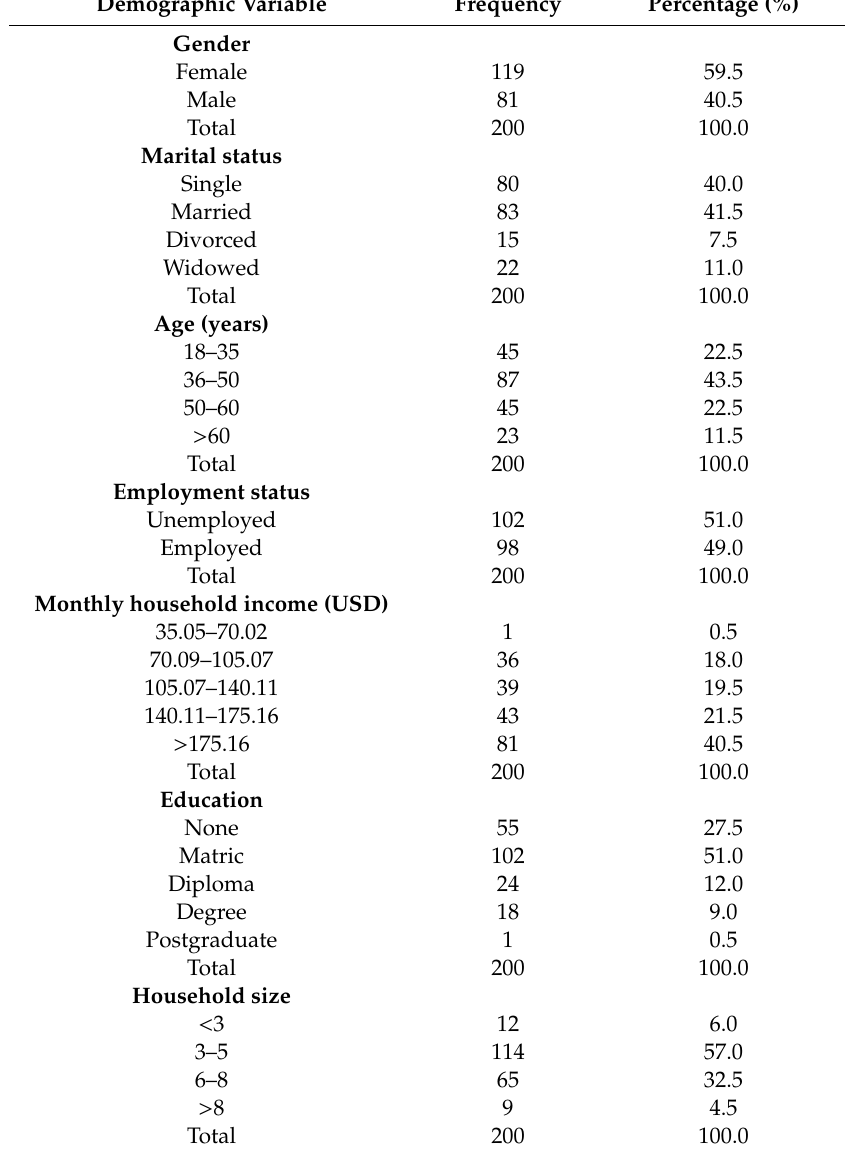
Table 1. The demographic characteristics of the respondents in the Durban South Basin (n =